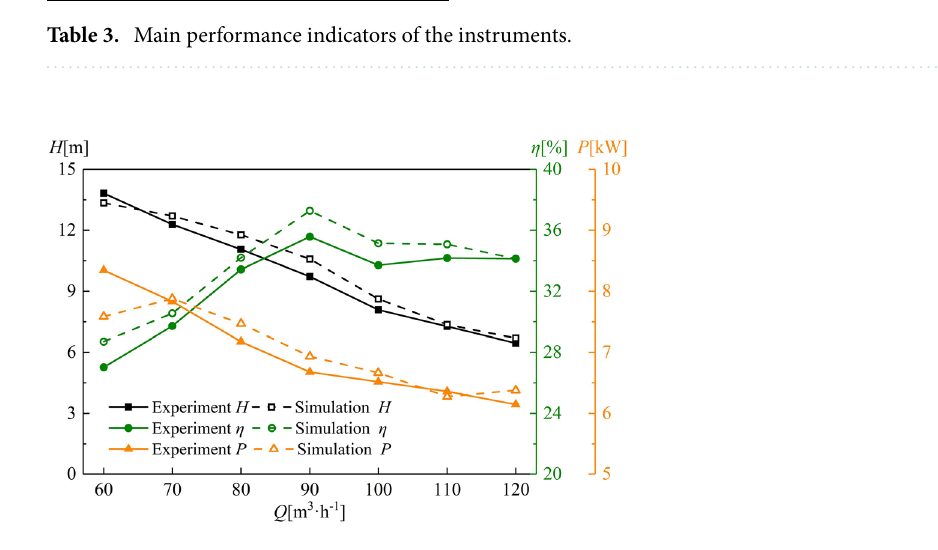
Figure 5. External characteristic lines of a multiphase